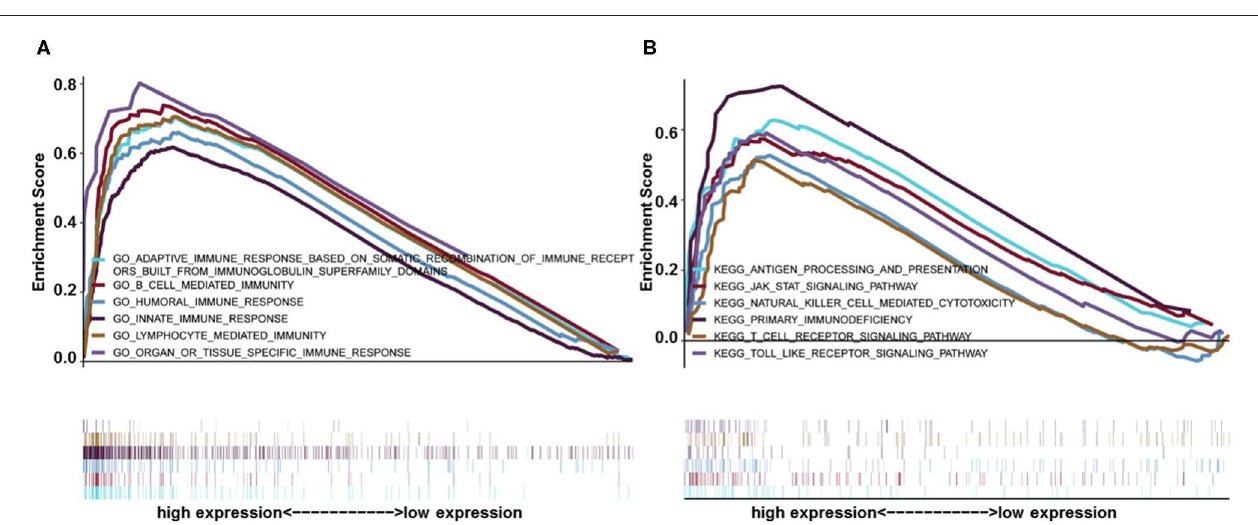
FIGURE 4 | GSEA enrichment analysis of HIST1H2BK using the CGGA database (LGG + GBM, n = 749). (A) Gene ontology adaptive immune response based on somatic recombination of immune receptors built from immunoglobulin super family domains, B cell mediated immunity, humoral immune response, innate immune response, and lymphocyte mediated immunity. These GO terms were differentially expressed between the high and low HIST1H2BK phenotypes. (B) Antigen processing and presentation, JAK/STAT signaling pathway, natural killer cell mediated cytotoxicity, toll-like receptor signaling pathway, and primary immunodeficiency pathways were differentially enriched between the high and low HIST1H2BK phenotypes.